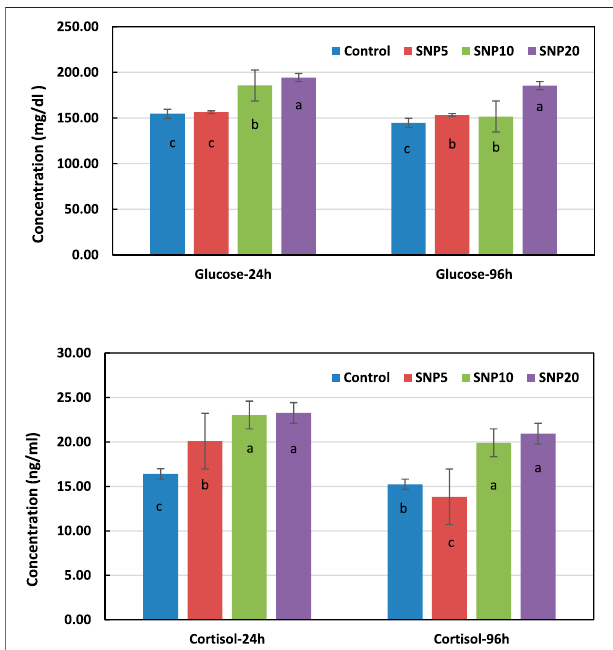
FIGURE 5 | Changes in rat serum glucose and cortisol concentrations after 24- and 96-h gavaging with different levels of silica nanoparticles including zero (as the control), 5 (SiNP5), 10 (SiNP10), and 20 (SiNP20). Data represent mean ± SD ( n = 3). Different letters indicate signi fi cant differences ( p < 0.05) (A,B) .